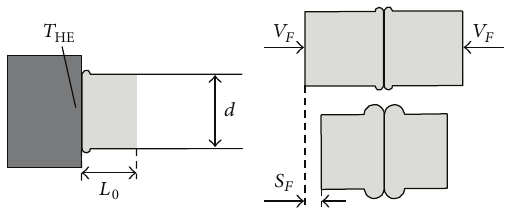
Figure 13: Selected process parameters in hot plate